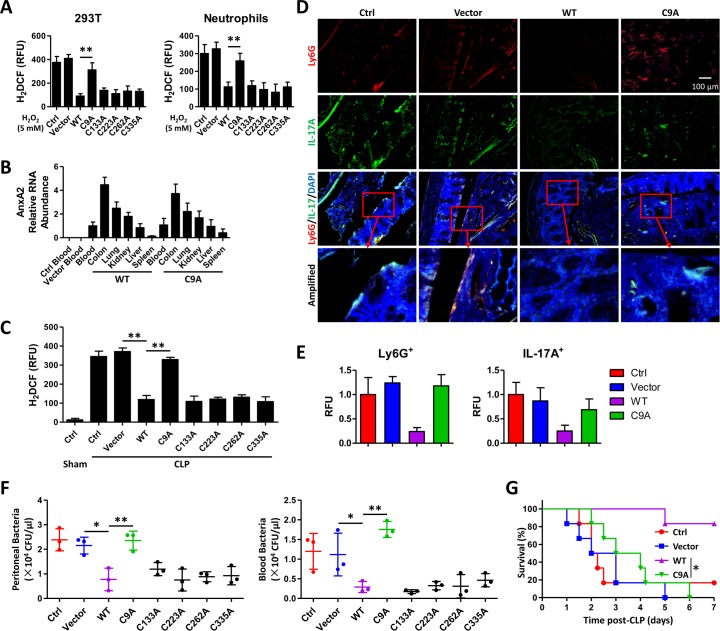
AnxA2 C9A mutation exacerbates host immunity in polymicrobial sepsis mice.(A) 293T cells and neutrophils from anxa2
-/- mice were transfected with AnxA2 WT, C9A, C133A, C223A, C262A, and C335A plasmids, respectively. After H2O2 treatment (5 mM, 30 min), ROS levels were measured using H2DCF assay. (B) anxa2
-/- mice were tail vein injected with these plasmids, respectively. 24 h later, mice were sacrificed and AnxA2 mRNA relative abundance in different organs or tissues were measured. (C) After plasmids transfection successfully, the mice were subjected to polymicrobial sepsis, and ROS levels were detected in PMs from mice at 24 h post-CLP. Means+SD from triplicate. (D, E) Immunostaining was performed for Ly6G+IL-17A+ cell accumulation detection in colon tissues from mice above. Fluorescence scores were quantified. (F) Peritoneal and blood bacteria were determined using CFU assay, means±SD from 3 mice. (G) Survival of mice (n = 6) above with polymicrobial sepsis was monitored. Kaplan-Meier survival curves (p = 0.0016, Log-rank Test). A-C, means+SD from 3 mice. D, E, data are representative from three independent experiments. One-way ANOVA (Tukey’s post hoc); *, p<0.05; **, p<0.01. Scale bar = 5 μm.